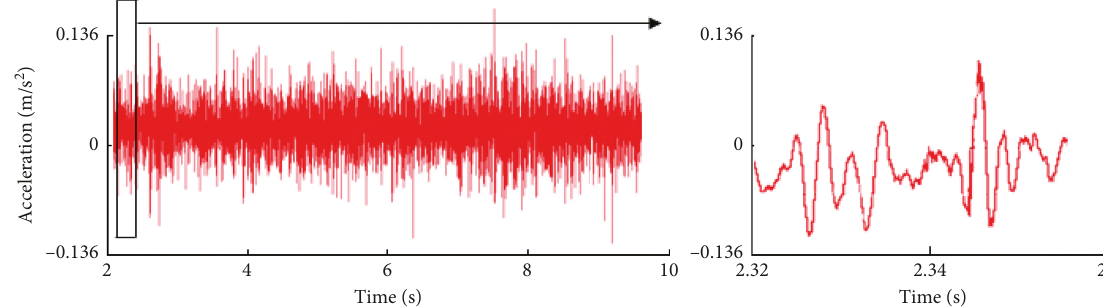
Figure 14: Tangential acceleration time-domain